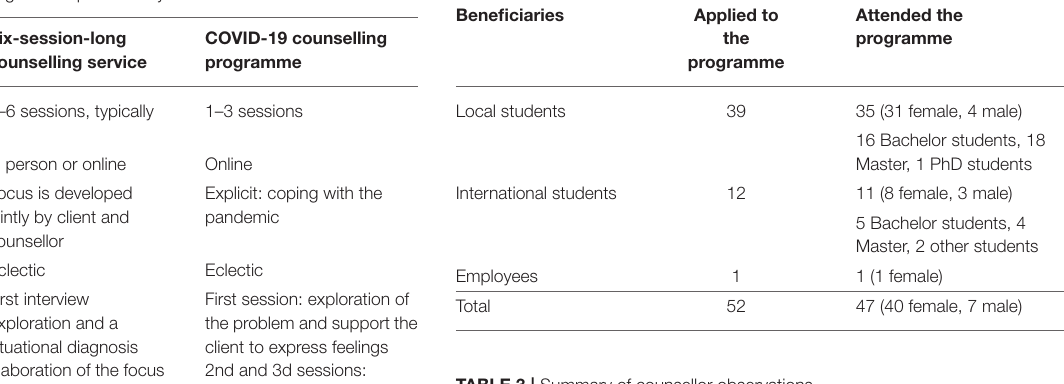
TABLE 1 | Comparing the COVID-19 counselling programme with the six-session-long counselling service provided by CC.